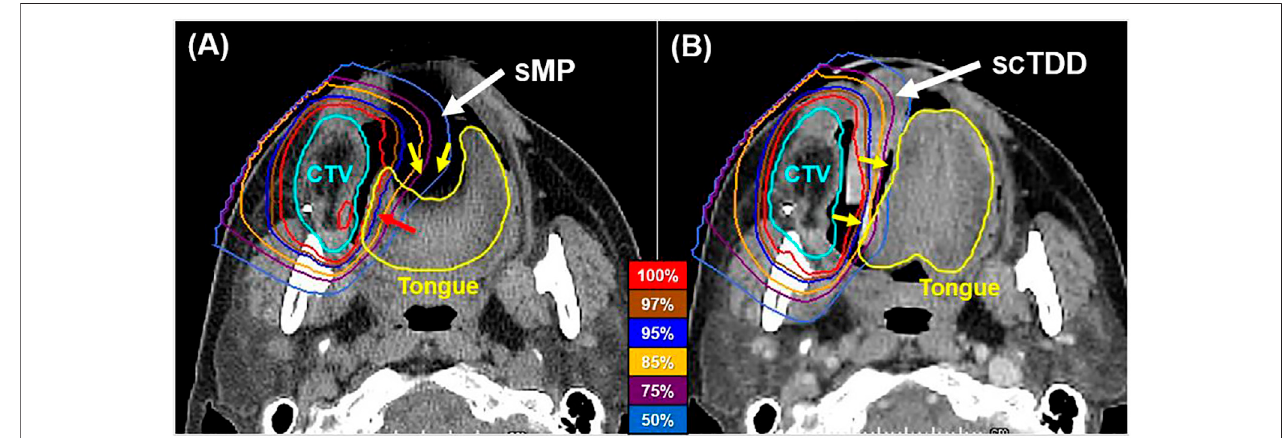
FIGURE 2 | Axial dose distributions of the S MP (A) and SC TDD (B) in a representative patient. The SC TDD reduced the dose to the tongue by effectively separating the tongue from the target volume. The yellow arrows indicate the tongue, which was depressed (left) and laterally displaced (right) when using the S MP and SC TDD, respectively.